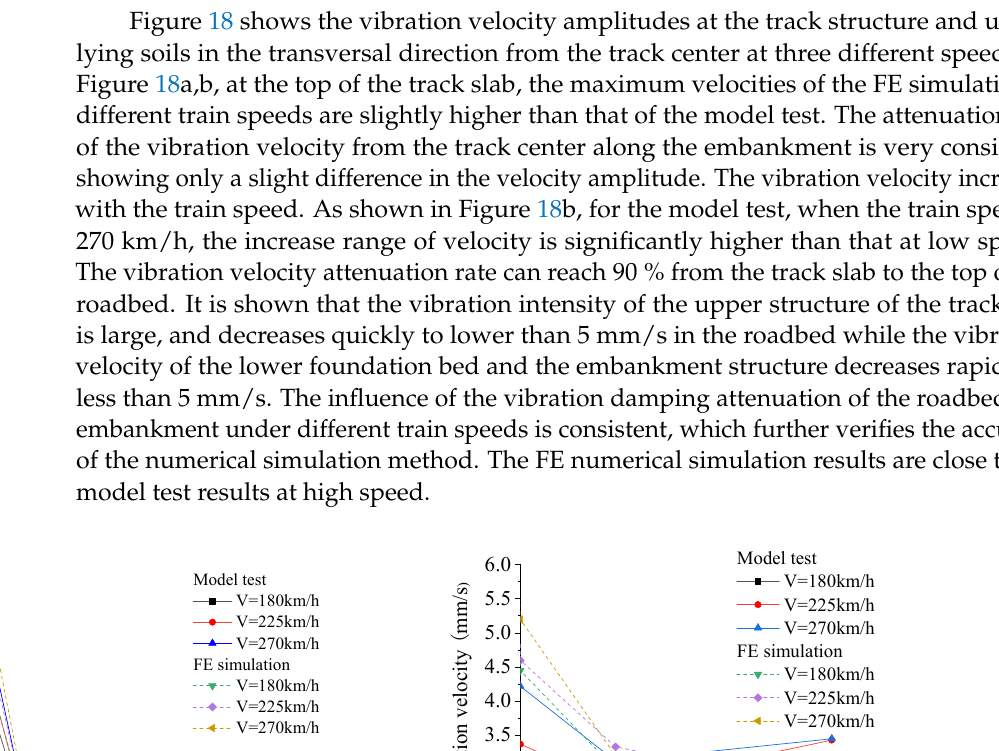
Figure 17. Comparisons of the vibration velocity between the FE and test results for train speed v = 270 km/h. ( a ) Track slab (V1, time domain), ( b ) Track slab (V1, frequency domain), ( c ) Roadbed (V5, time domain), ( d ) Roadbed (V5, frequency domain), ( e ) Raft (time domain), ( f ) Raft (frequency domain), ( g ) Cushion (time domain), ( h ) Cushion (frequency domain), ( i ) Bottom of subsoil (time domain), ( j ) Bottom of subsoil (frequency domain).